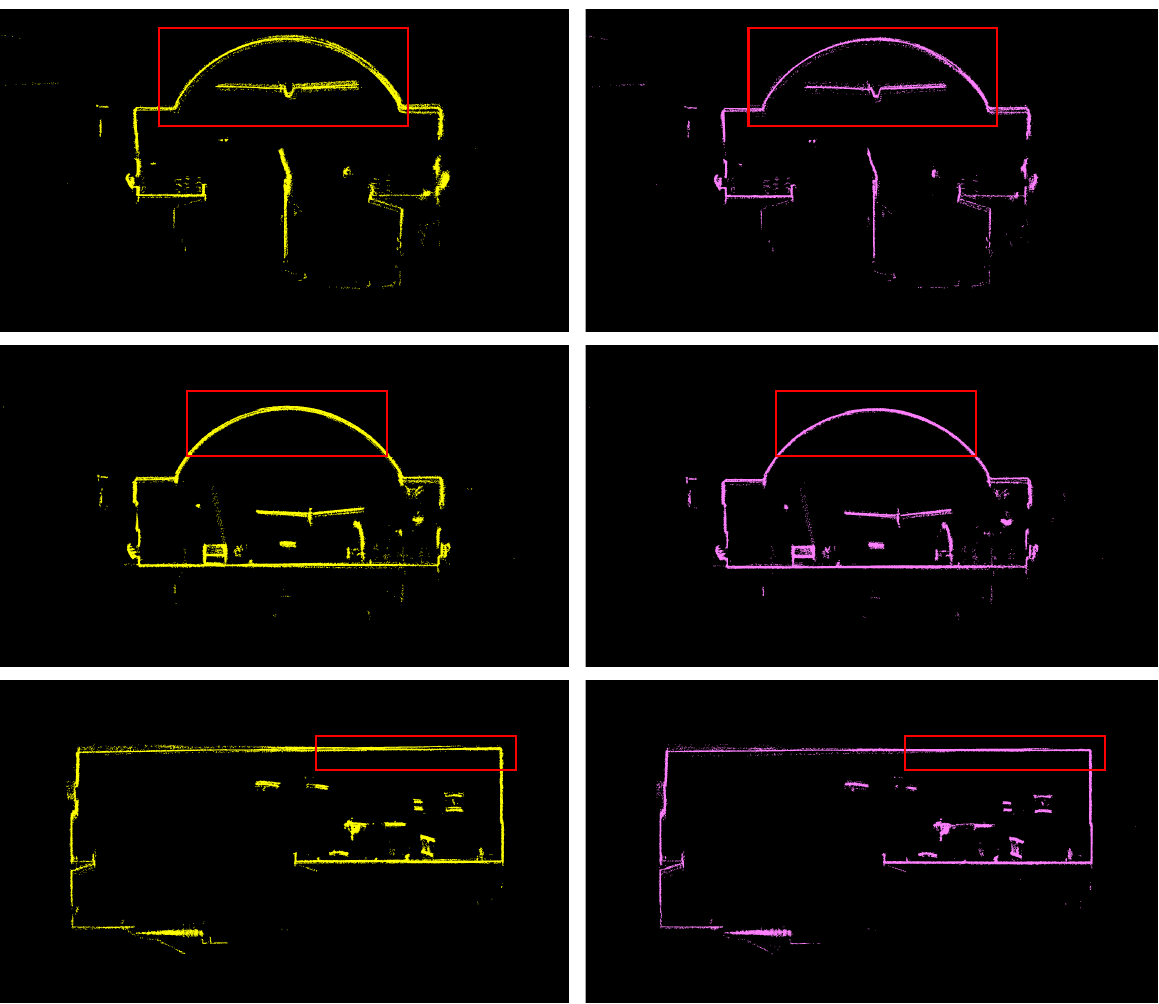
Figure 4: Results of continuous-time SLAM on Google’s Cartographer sample data set Deutsches Museum in M¨unchen. Left: input. Right: output of our solution. Shown are sectional views of the museum hall. Major changes in the point cloud are highlighted in red.